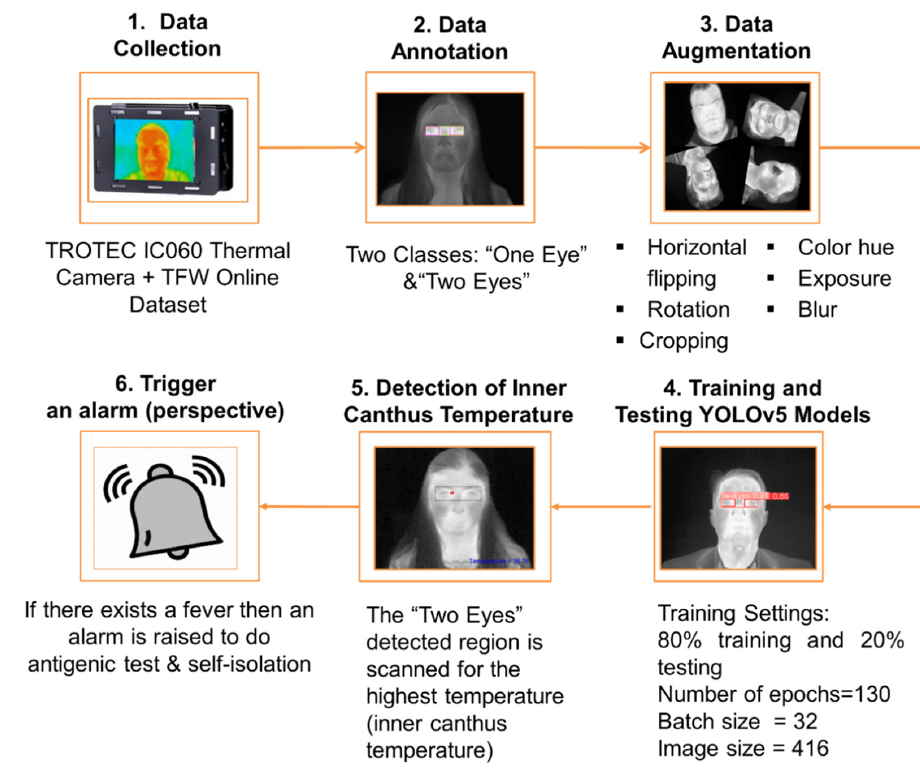
Figure 1. The methodology followed in this